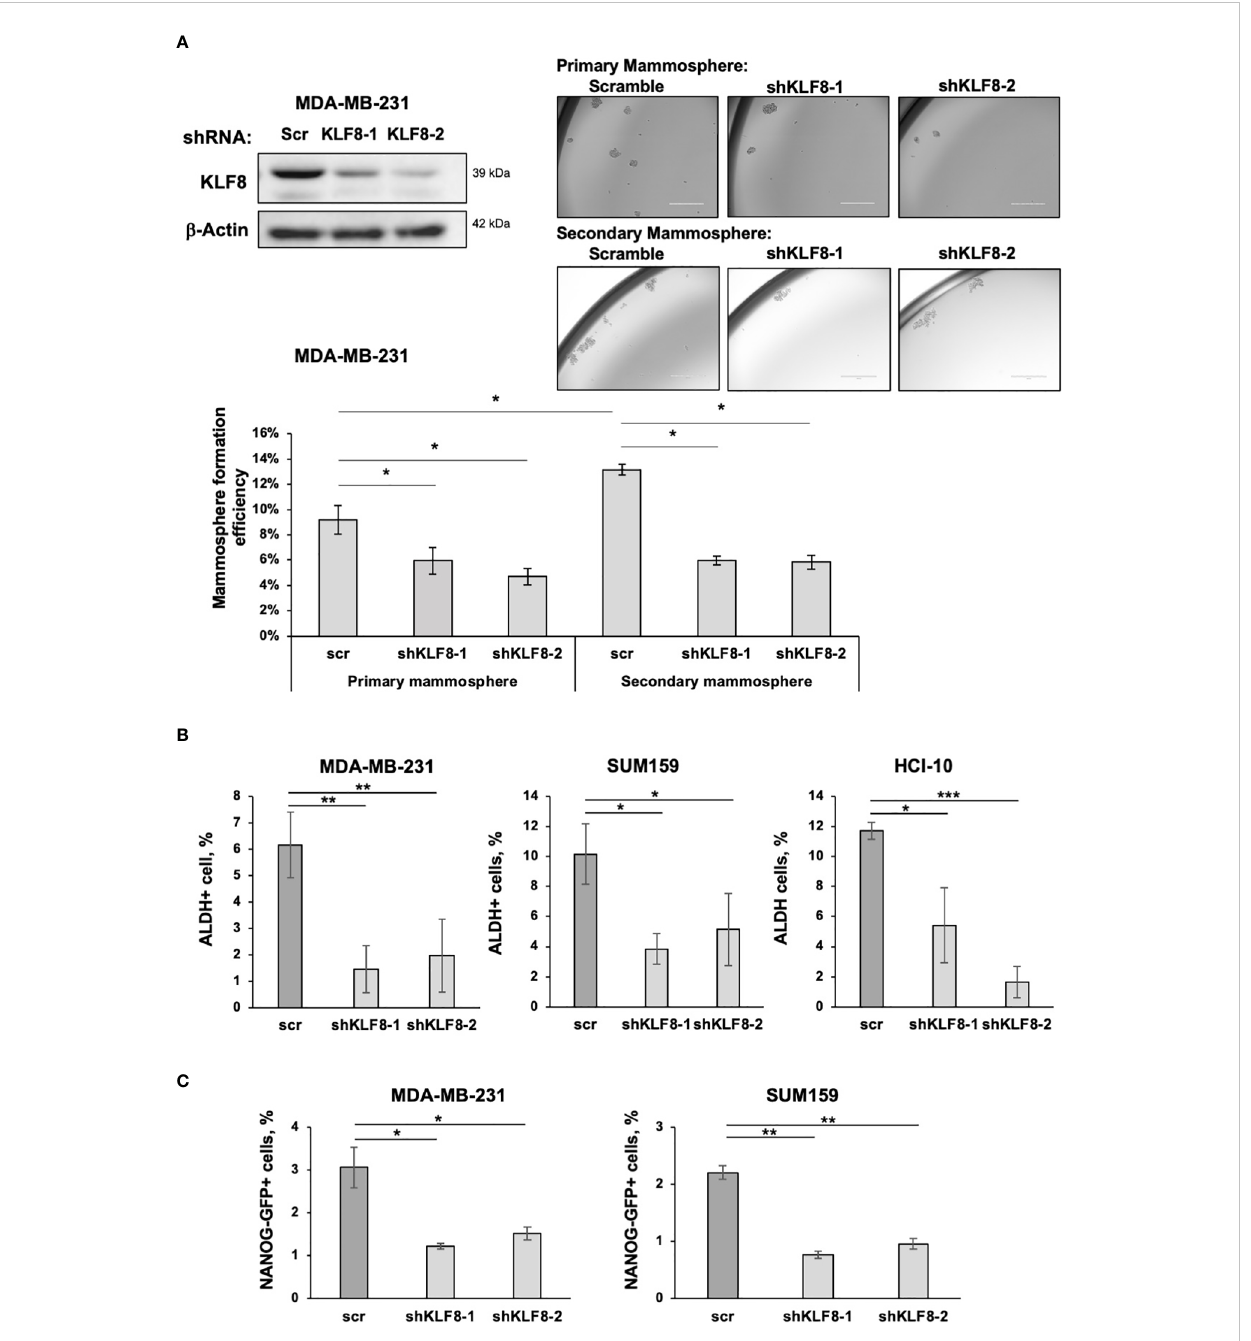
FIGURE 1 KLF8 inhibition reduced mammosphere formation and CSCs population in TNBC cells. (A) Lysates from MDA-MB-231 cells stably expressing control or KLF8 shRNA was collected for immunoblot analysis using antibodies against indicated proteins (top-left). MDA-MB-231 cells transduced with control or KLF8 shRNA were grown in mammosphere formation assay for 5-7 days. Representative images of mammosphere were taken (top-right) (scale bar 400 m m), and mammosphere larger than 50µm were counted and primary mammosphere formation ef fi ciency was quanti fi ed by fractionating counted mammosphere number from total cells plated at the beginning of the assay. Primary mammosphere were then collected and culture again in mammosphere culture condition for 5-7 days to form secondary mammosphere (bottom). (B) Quanti fi ed graph of ALDH+ CSCs population detected by fl ow cytometry from MDA-MB-231, SUM159 and PDX cells HCI-10 stably expressing control or KLF8 shRNA. (C) Quanti fi ed graph showing NANOG-GFP+ CSCs population detected by fl ow-cytometry from MDA-MB-231 and SUM159 cells stably expressing control or KLF8 shRNA. Student t test reported as mean ± SEM, *p<0.05, **p<0.01, and